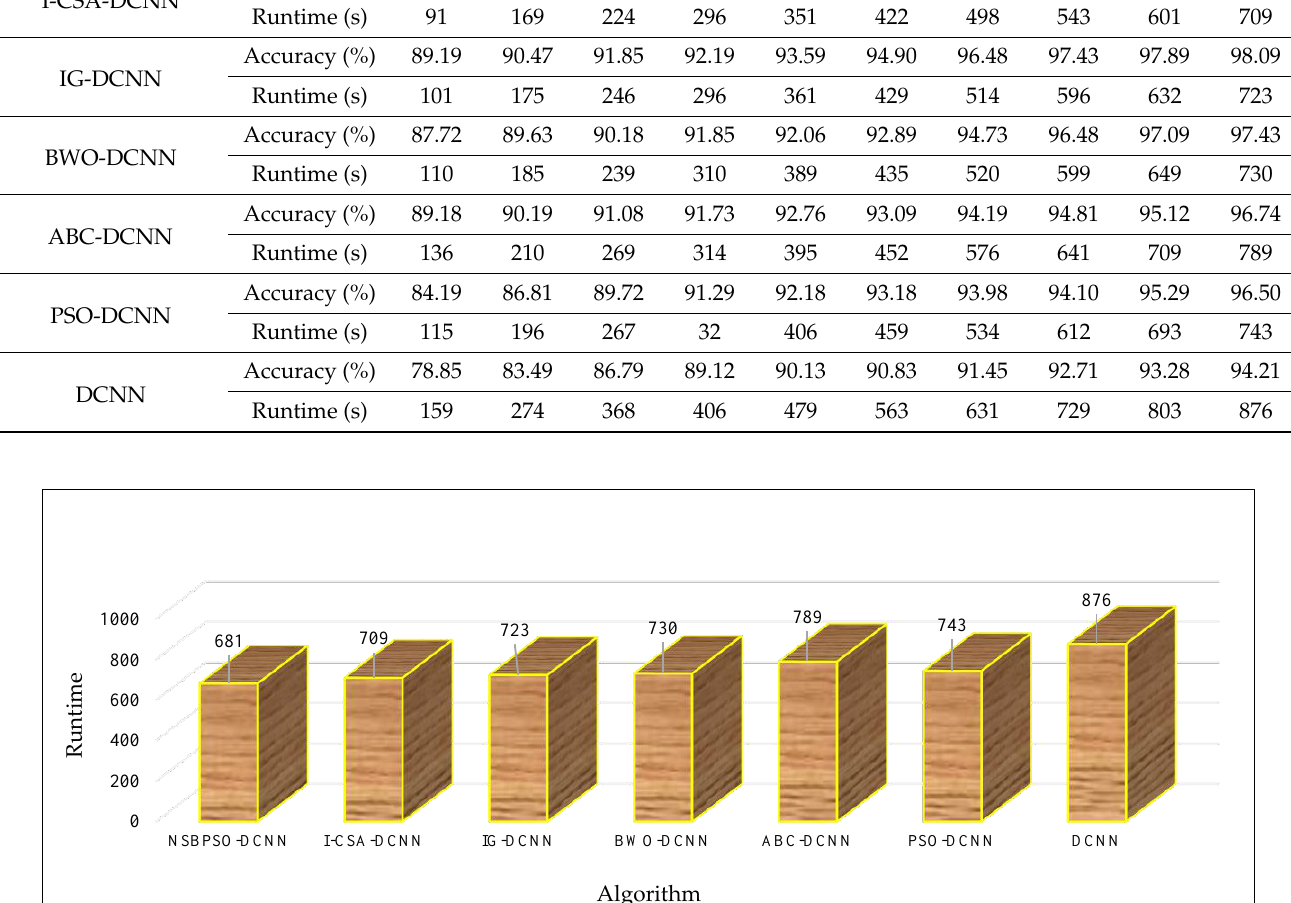
Table 4. Accuracy and runtime of the models for different epochs.